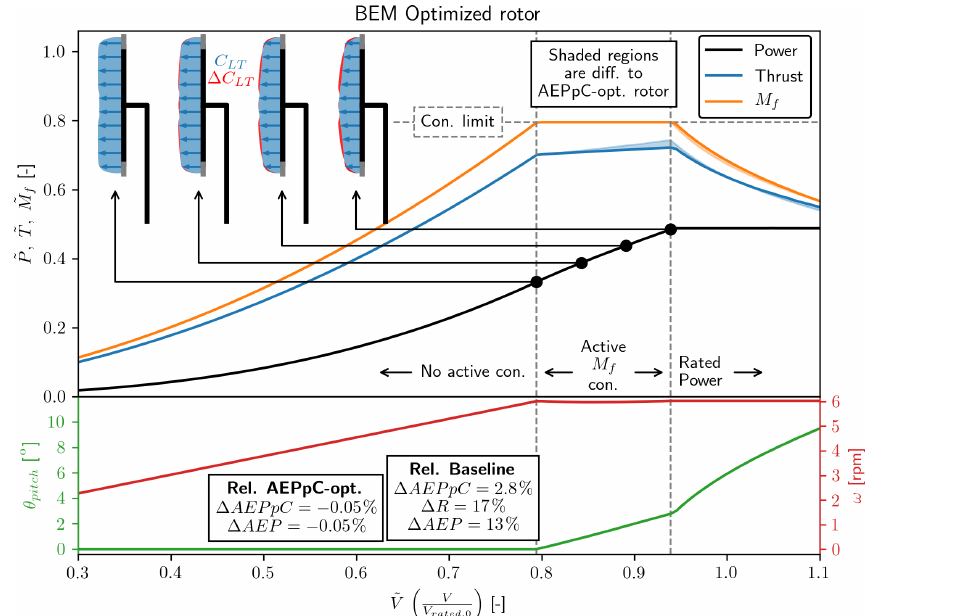
Figure 13. Power and load curves (top curves) as well as blade pitch ( θ pitch – left y axis) and rotor rotational speed ( ω – right y axis) as a function normalized wind speed ( ˜ V ) for the BEM-optimized rotor. Rotor loading at four selected points is shown, with the red region showing the difference to the AEPpC-optimized power curve load. The difference between the AEPpC and BEM-optimized rotor in terms of AEPpC is seen to be insignificant with a difference of